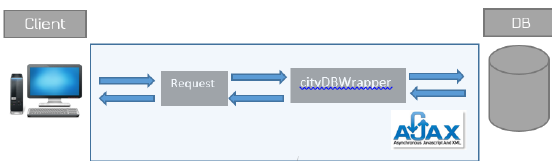
Figure 5. Asynchronous communication between Client and DB